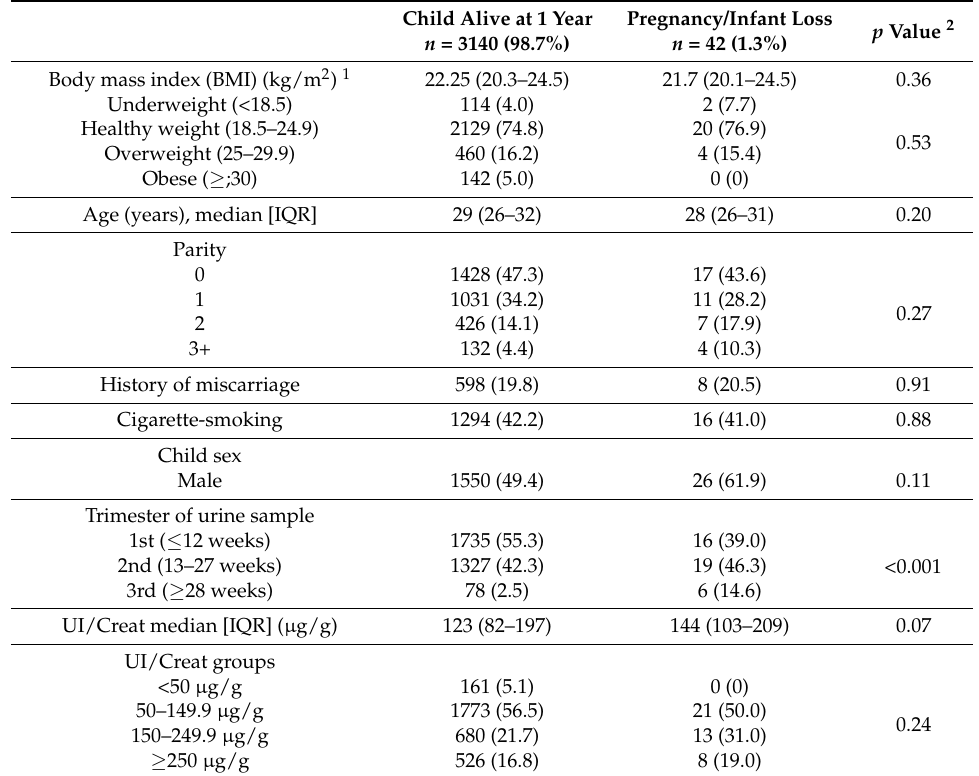
Table 1. Demographic characteristics and urinary iodine-to-creatinine (UI/Creat) measurements in women with a child alive at 1 year and those who experienced pregnancy/infant loss up to 1